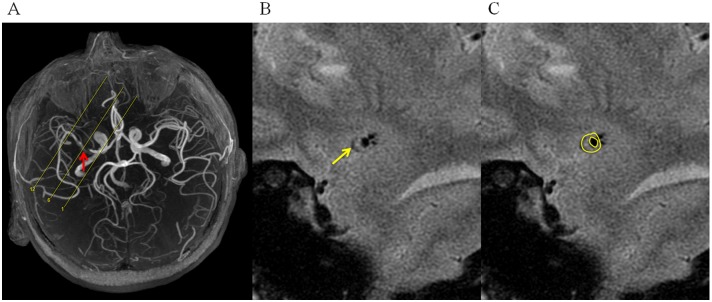
Image acquisition and segmentation of middle cerebral artery (MCA) plaque.(A) Prescription of slices perpendicular to MCA base on the maximal intensity projection (MIP) of 3D TOF images. Red arrow shows the stenosis site. (B) Sample images (slice number 6) shows MCA plaque (yellow arrow). (C) Segmentation of the MCA lumen and outer wall boundaries.